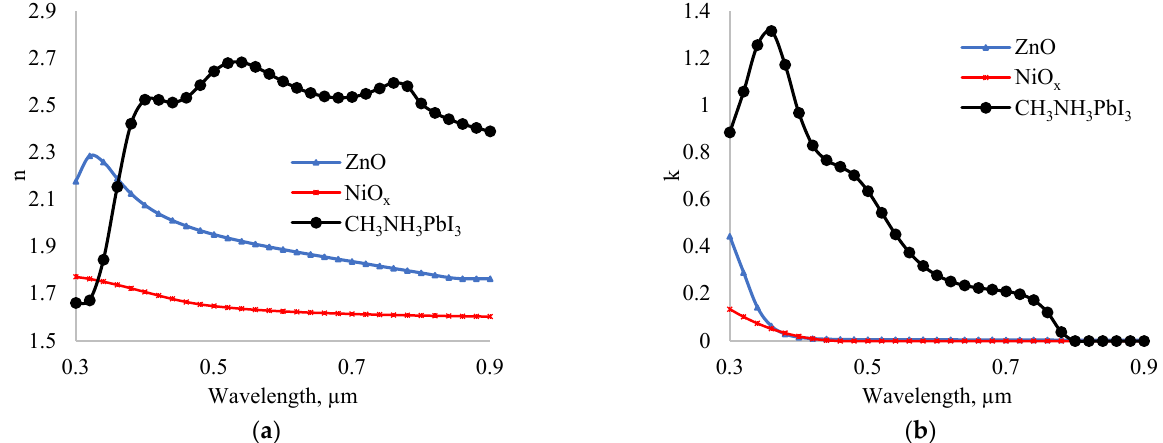
Figure 2. Dependence of real ( a ) and imaginary ( b ) parts of the complex refractive index of ZnO, NiO x , and CH 3 NH 3 PbI 3 on the incident light wavelength.